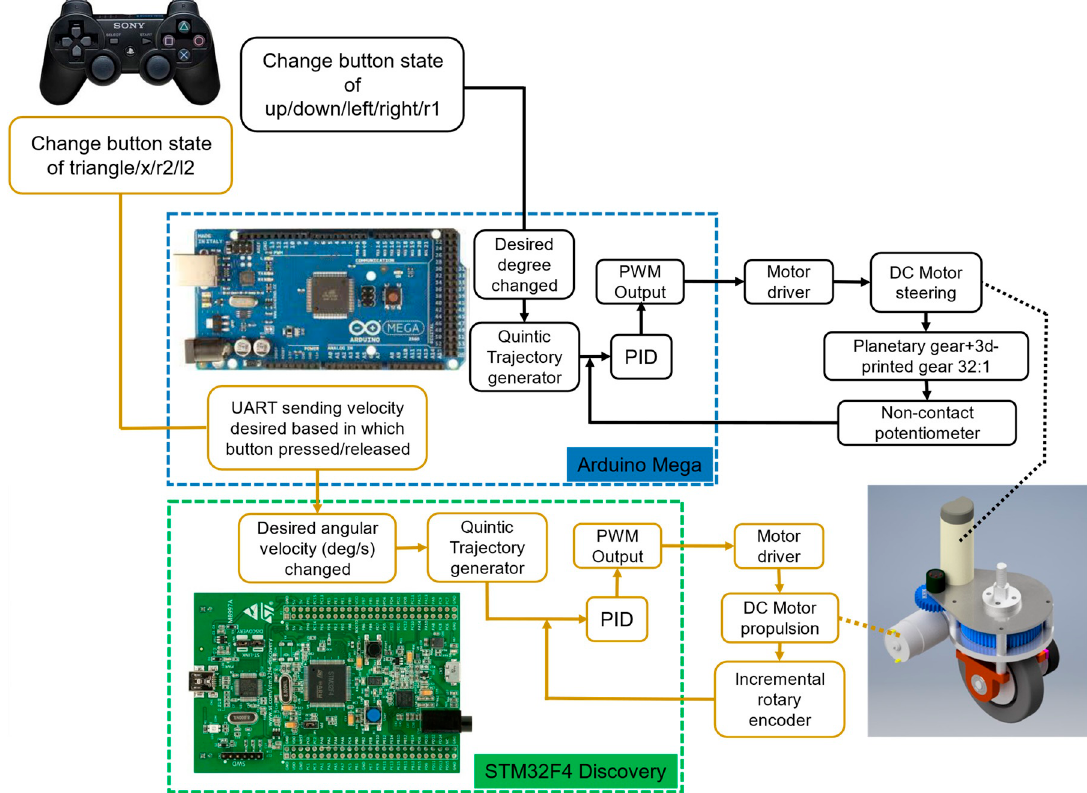
Figure 2. Schematic of the interconnection of the electrical and control aspects.